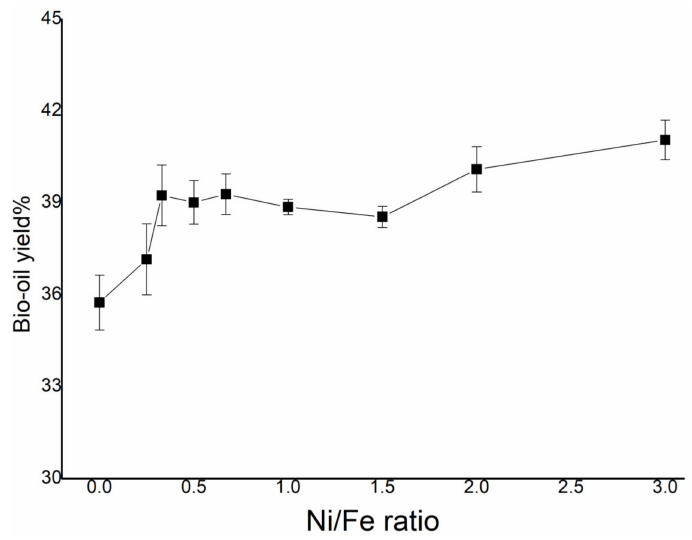
Figure 7. The relationship between bio-oil yield and Ni / Fe ratio for all catalysts (value = 0 means without catalyst).